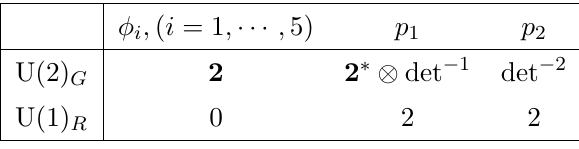
Table 9 . Field content of GLSM for X 2 ; 5